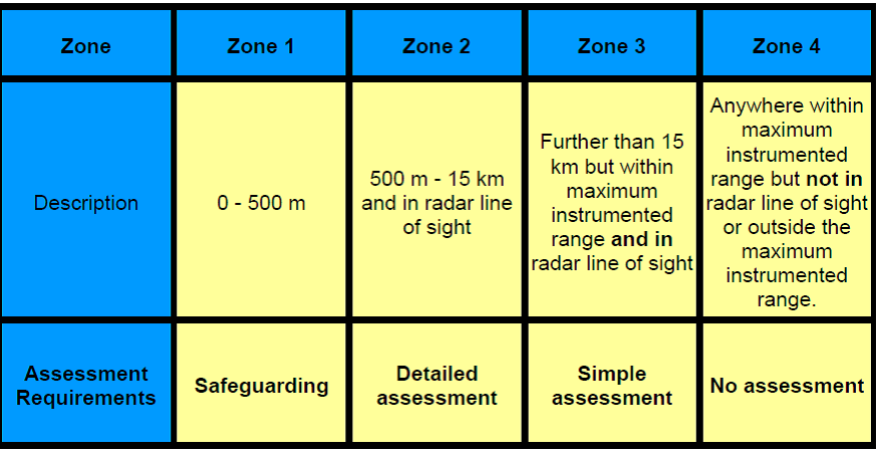
Figure 3. Zonal parameters for safeguarding distances and impact assessment (Source: